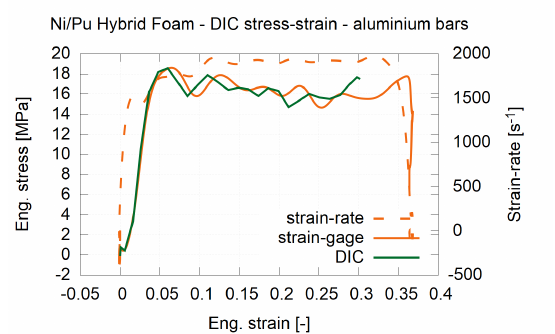
Figure 5. Comparison of stress-strain diagrams with strain evaluated using strain-gage and DIC, experi- ment no. 270